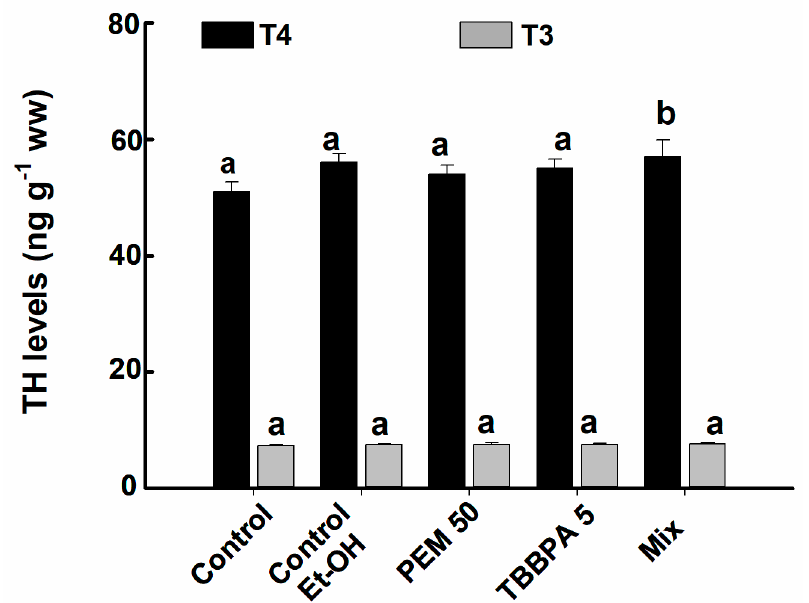
Figure 2. Level of thyroxine (T4) and triiodothyronine (T3) in shrimp whole body after 96 h of exposure to the following different experimental groups ( n = 10 for each aquarium): Control, Control- EtOH, PEM 50 (polyethylene microplastics, 50 µ g L − 1 ), TBBPA 5 (TBBPA, 5 µ g L − 1 ), and Mix group (the mixture of 50 µ g L − 1 polyethylene microplastics and 5 µ g L − 1 TBBPA). Data are expressed as median ± SE. Different lowercase letters denote significant differences among experimental groups ( p < 0.05, Kruskal–Wallis H test, followed by a posteriori multiple comparisons of mean ranks for all groups).